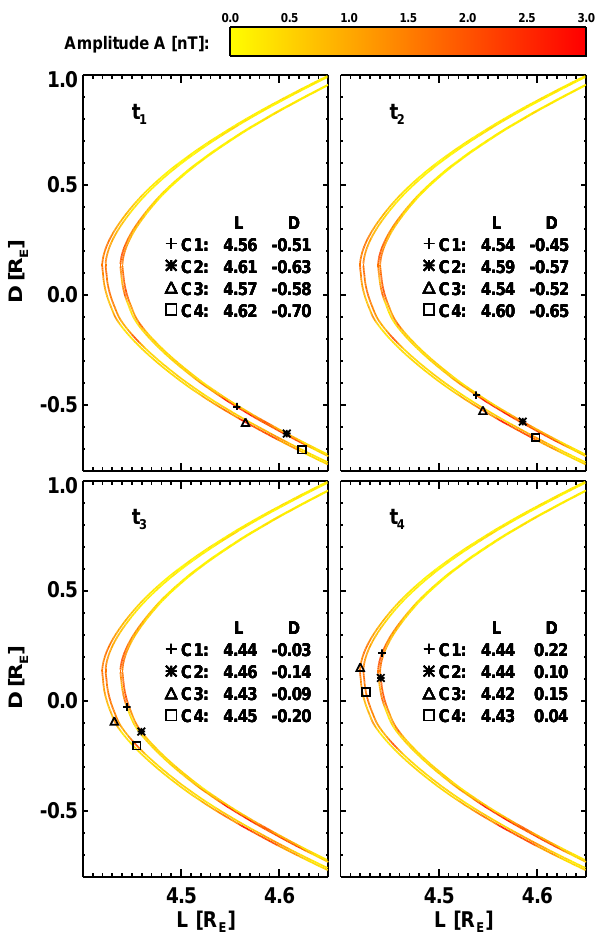
Fig. 6. Cluster orbits in L-D coordinates at t 1 − t 4 . The spacecraft move from negative to positive D values across the magnetic equa- tor ( D = 0 R E ). The color index gives the instantaneous amplitude of the transverse magnetic field oscillation.